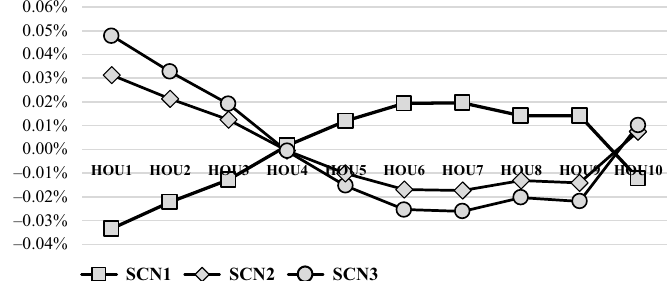
Figure 9. Changes in the share of each income quantile group in 2030 (%p relative to the BAU) 6